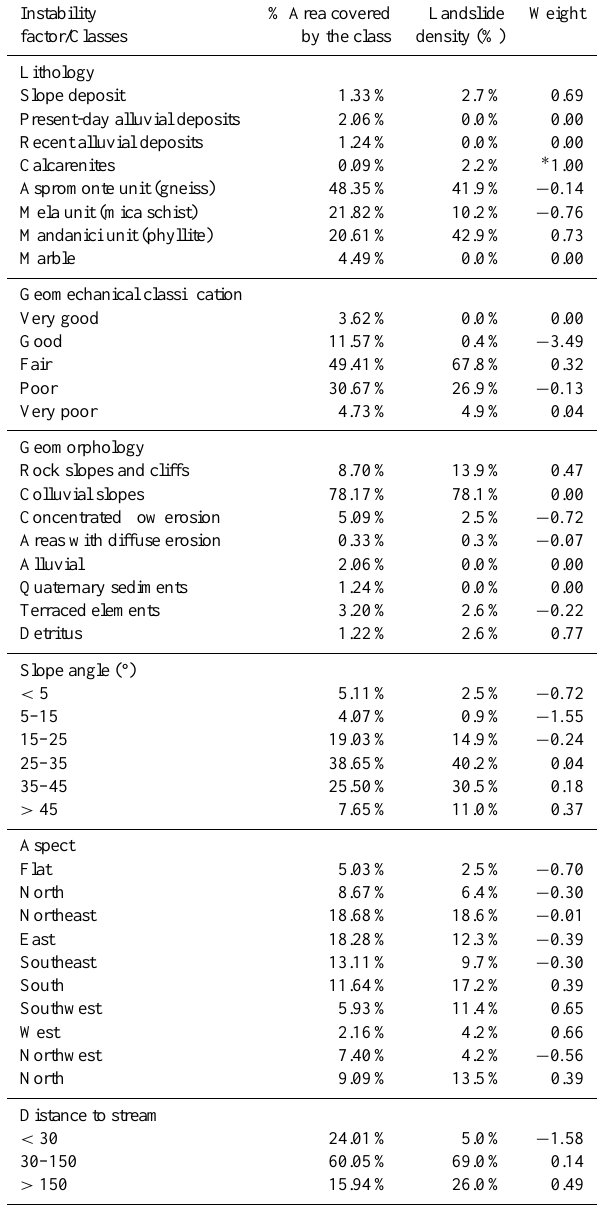
Table 1. Calculated weights in the training areas for the classes of the six causative factors; ∗ arbitrarily assigned.